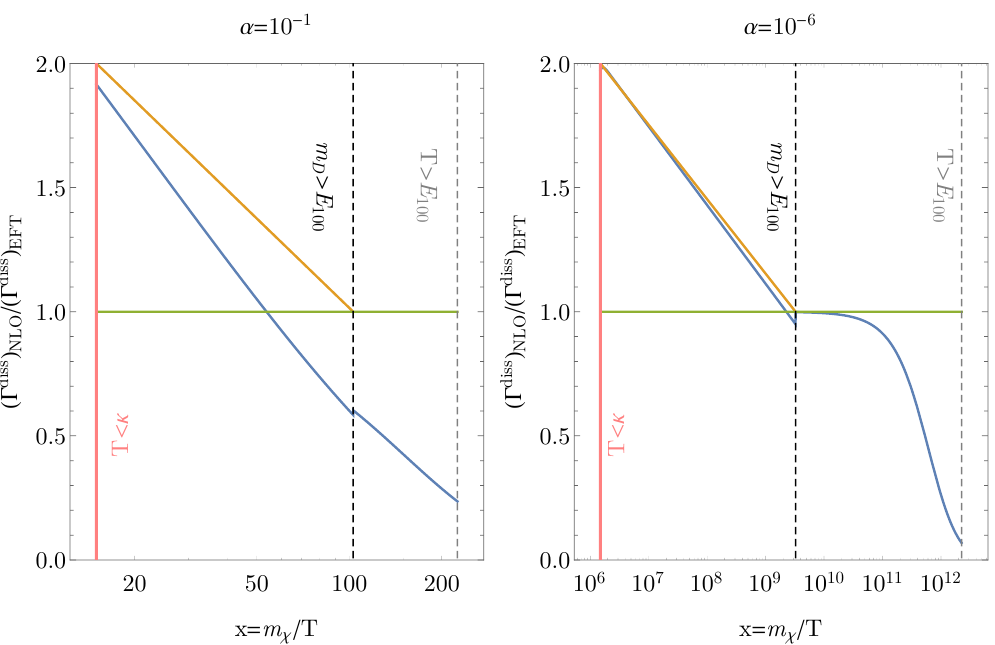
Figure 10. Ratios (blue lines) of the 1S state dissociation rate in our calculation and that in ref. [115] for two values of the coupling constant α . Only the fermion loop contribution (diagram ( f ) ) is included in the comparison, since the gauge sector of ref. [115] is not gauge invariant. In the hierarchy κ (cid:29) T (cid:29) E (cid:29) m D where HTL resummation is not important, the two calculations agree well when the scales are largely separated. In the hierarchy κ (cid:29) T (cid:29) m D (cid:29) E where HTL resummation is important, our fixed order result overestimates that in ref. [115] by a logarithmic factor, C ( T ) , depicted by the yellow